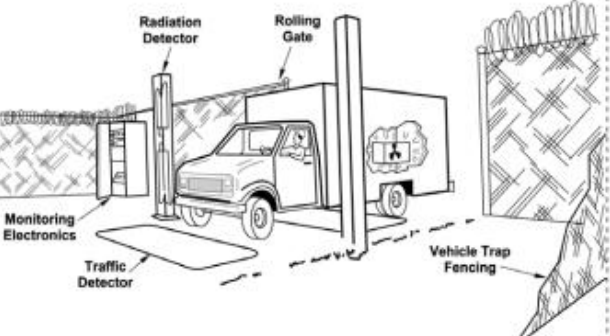
Figure 9. Example of a portal configuration for detecting authorized and non-authorized nuclear material [18]